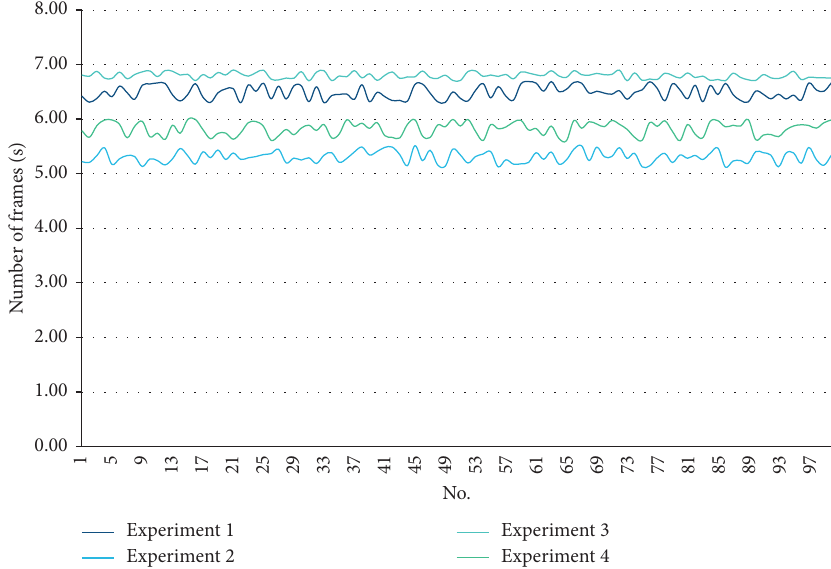
Figure 14: Statistical diagram of the processing speed in the frame selection partition fusion mode (frames/sec). Table 3: Statistical table of the accuracy of pedestrian